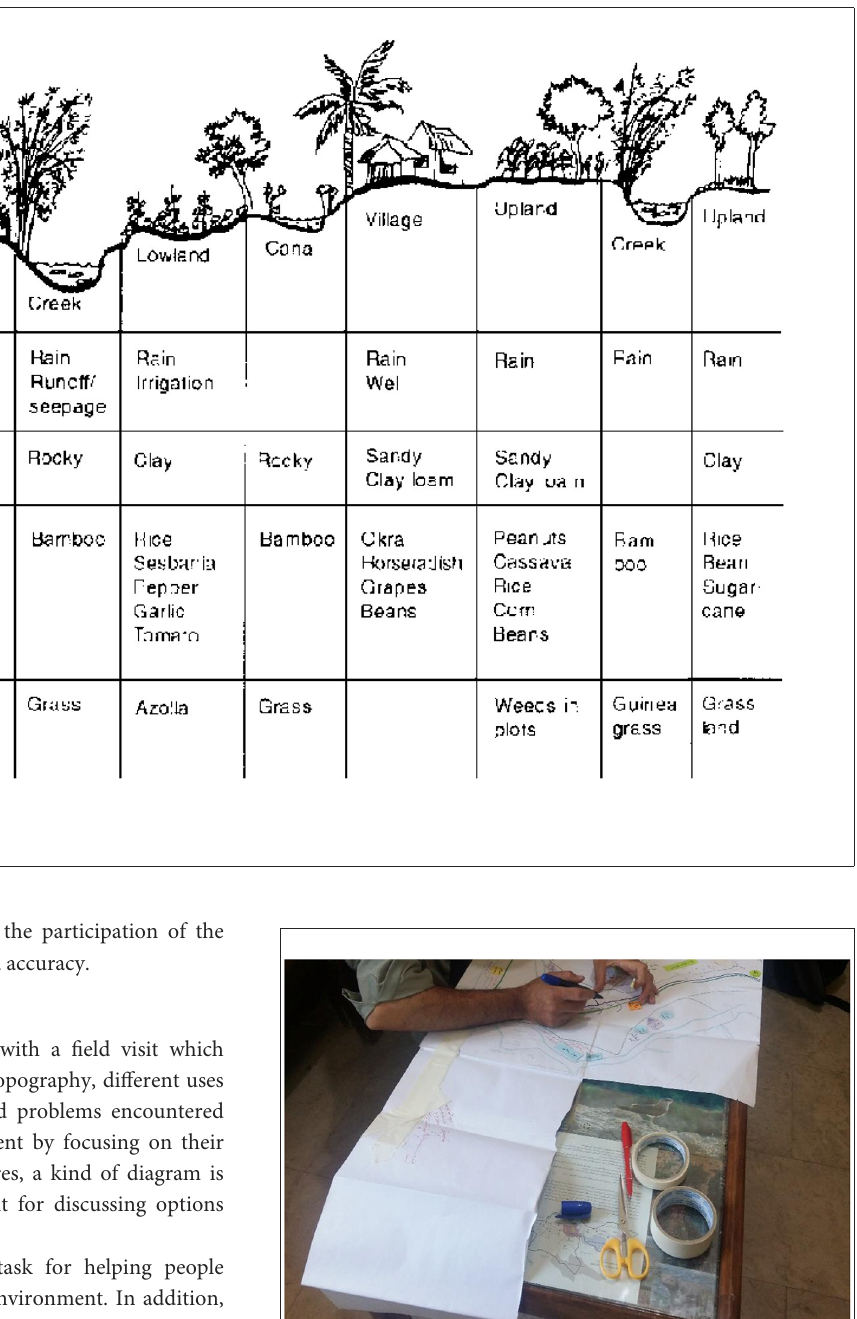
and outskirts of Lar National Park, village pastures, crowded roads, contract borders with other villages, and the fish shops and ponds where the locals worked were